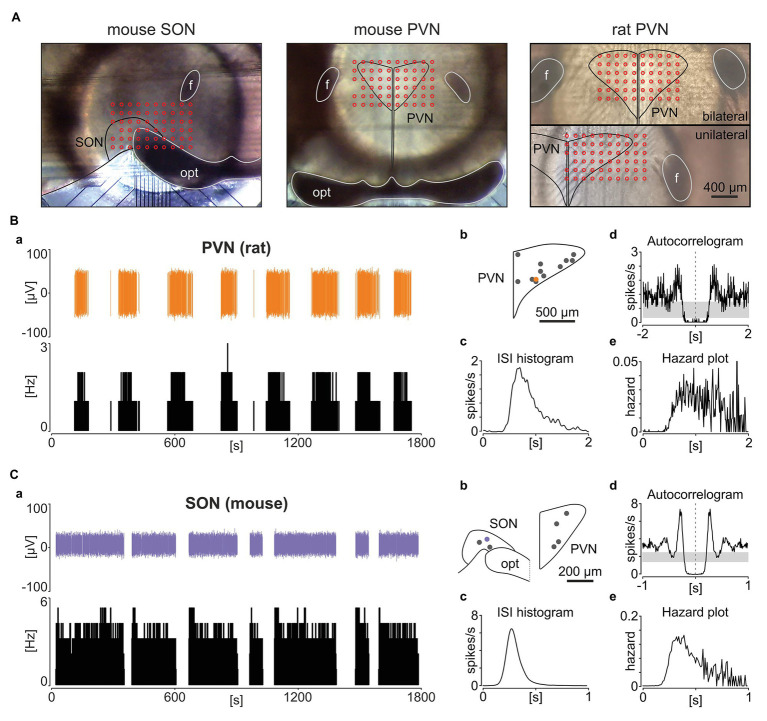
Phasic activity pattern in the rat and mouse hypothalamic paraventricular (PVN) and supraoptic nuclei (SON). (A) Photographs showing example hypothalamic slices mounted on the multi-electrode array with the SON and PVN outlined in black and the location of recording electrodes depicted by red circles. opt – optic tract, f – fornix. (B,C) The panel (B) shows a representative rat PVN phasic unit, whereas (C) depicts a phasic cell in the mouse SON. (a) Single units with their corresponding firing rate histograms (bin: 1 s). (b) Anatomical reconstruction showing the localisation of recorded units. opt – optic tract. (c) ISI histograms. (d) Autocorrelograms with the 95% CIs coded by grey boxes. (e) Hazard plots describing the probability of ISI after each spike. Bins for (d,e) are 10 ms.